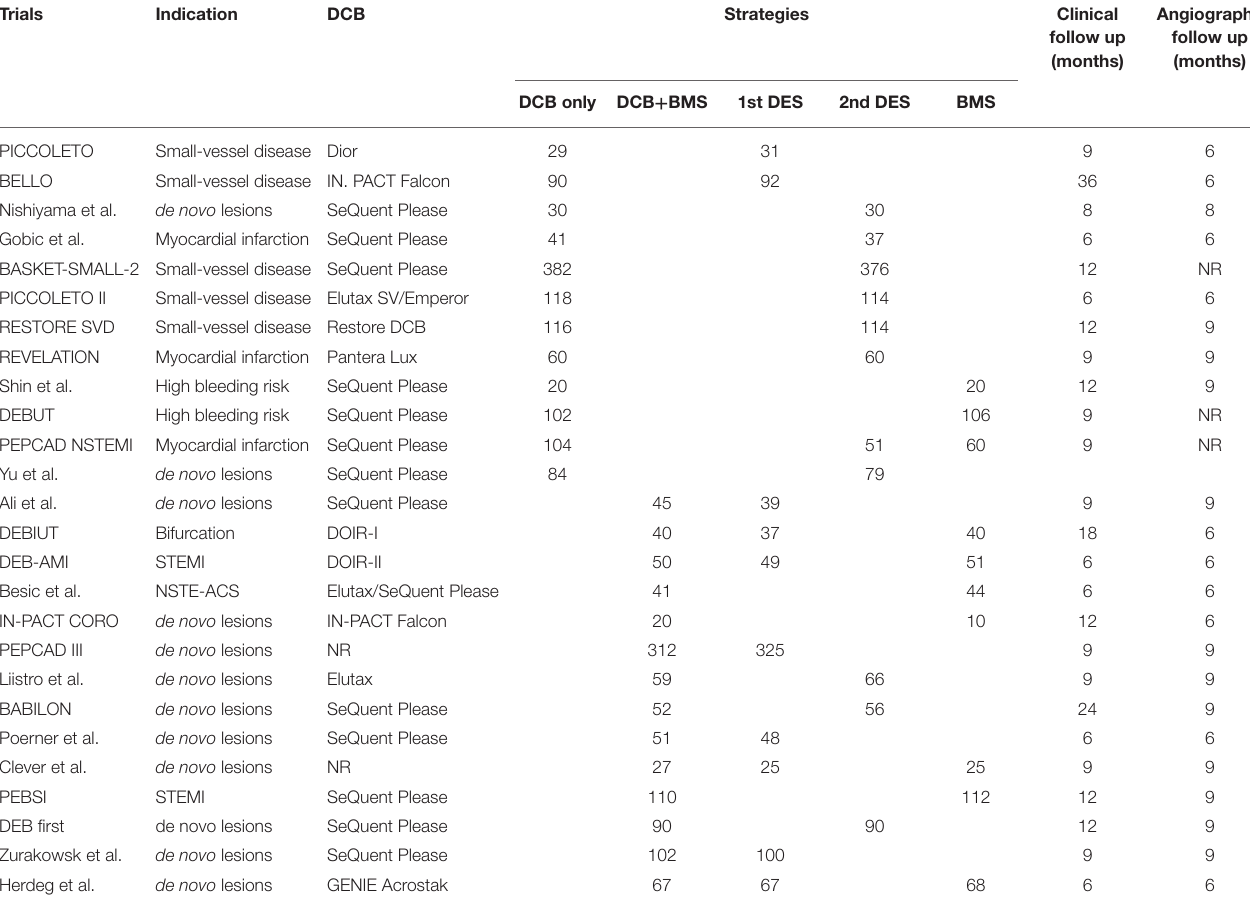
TABLE 1 | Characteristics of included